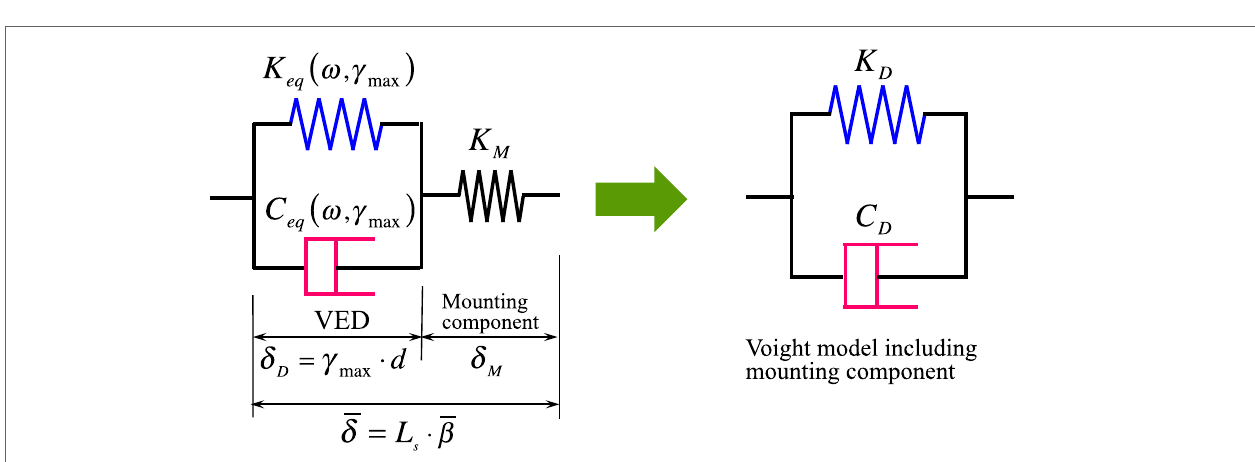
FIGURE A1 | Earthquake interstory drifts of hypothetical 15- and 24-story buildings . (A) Interstory drift of 8th floor of a 15-story building subjected to Hachinohe 1968 EW earthquake ( Figures 4B and 11 ). (B) Interstory drift of 24th floor of a 24-story building subjected to El Centro 1940 NS earthquake ( Figure 12 ).